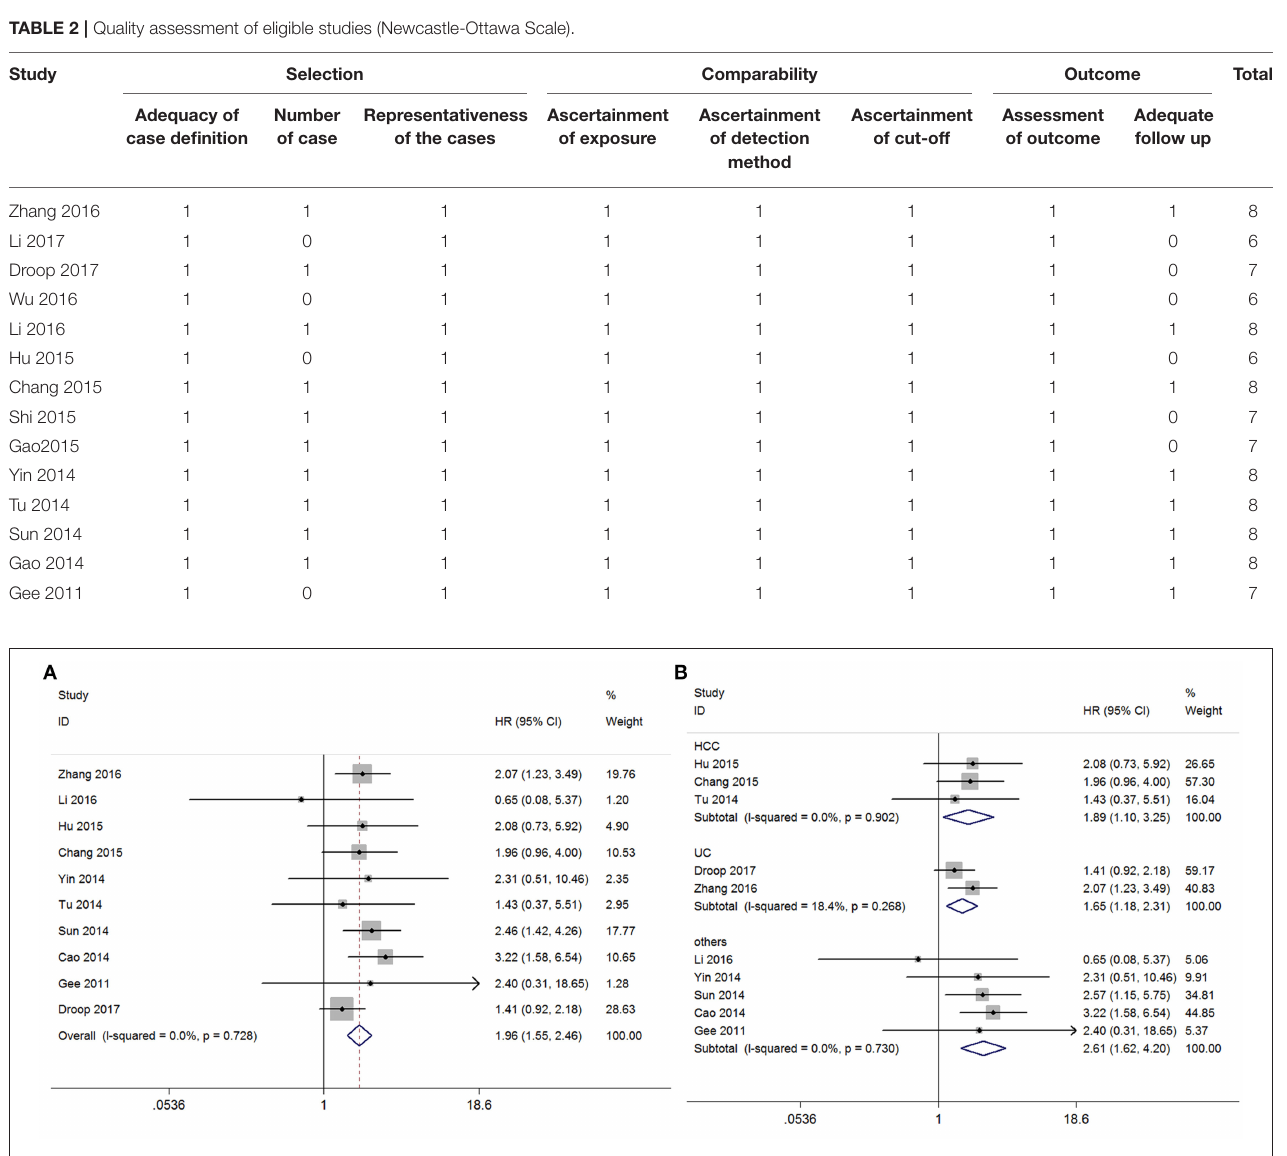
FIGURE 2 | Meta-analysis of the pooled HRs of OS of different types of cancer with the level of GAS5 expression. (A) Forest plot for the correlation between GAS5 expression levels and OS in different cancer patients. (B) Subgroup analysis of HRs of OS by factor of different types of cancer.